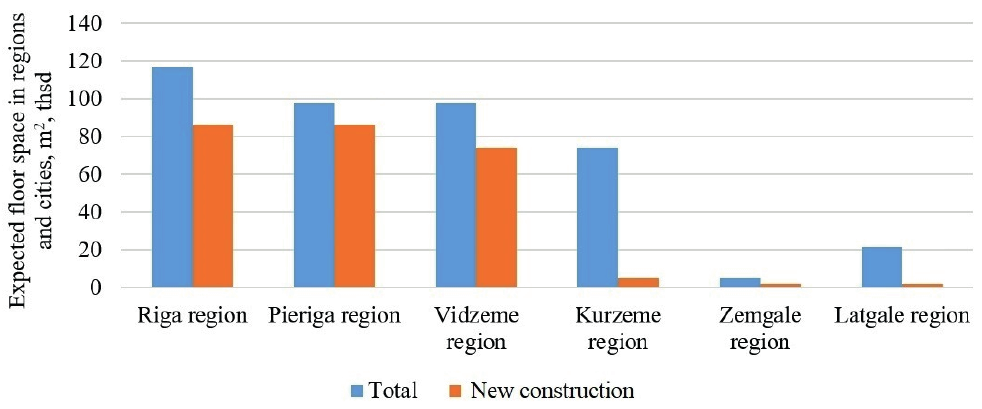
Fig. 9. Expected floor space in statistical regions and cities under state jurisdiction by quarter; two and more dwelling buildings in the period of 2020Q4–2021Q3, m 2 , thsd (developed by the authors based on European Statistics Database